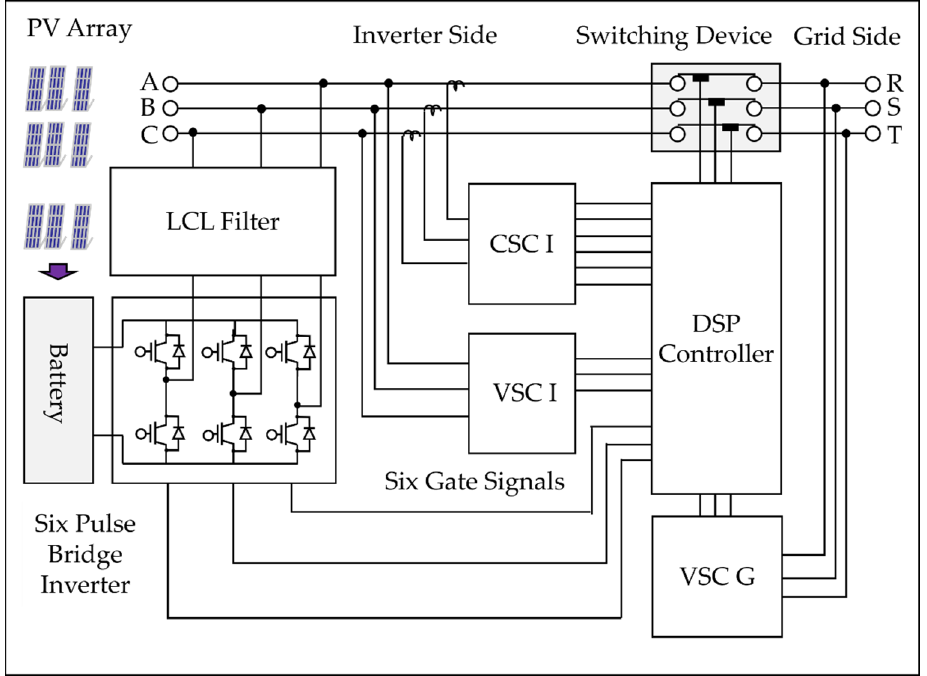
Figure 4. Configuration of the micro DG.